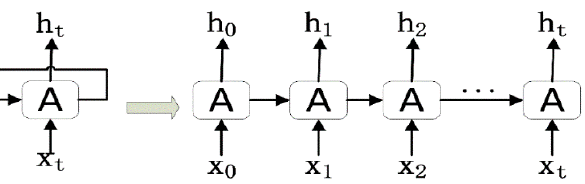
Figure 2. Expanded RNN in time sequence.